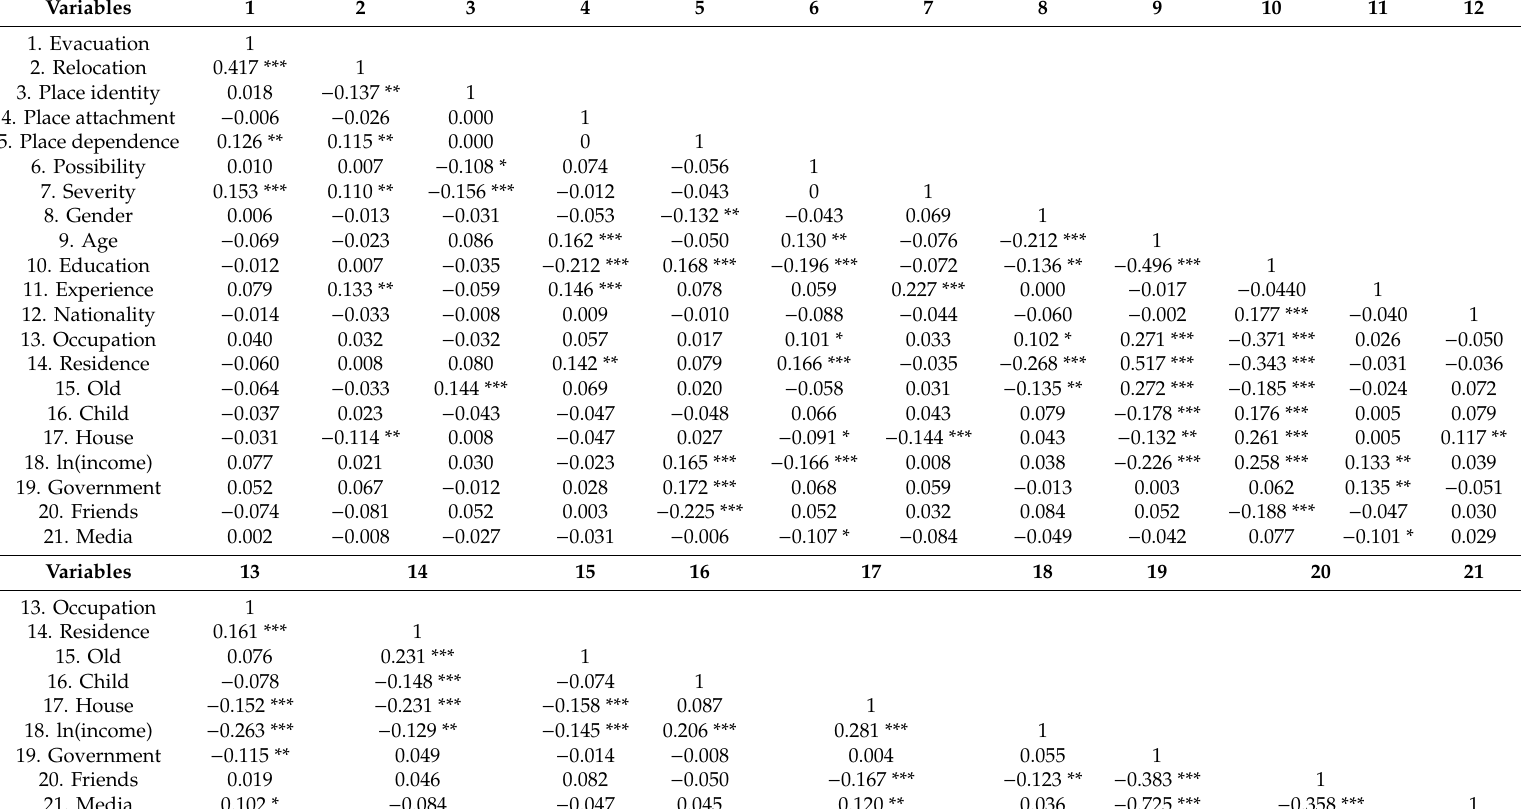
Table 5. Correlation coe ffi cient matrix of model